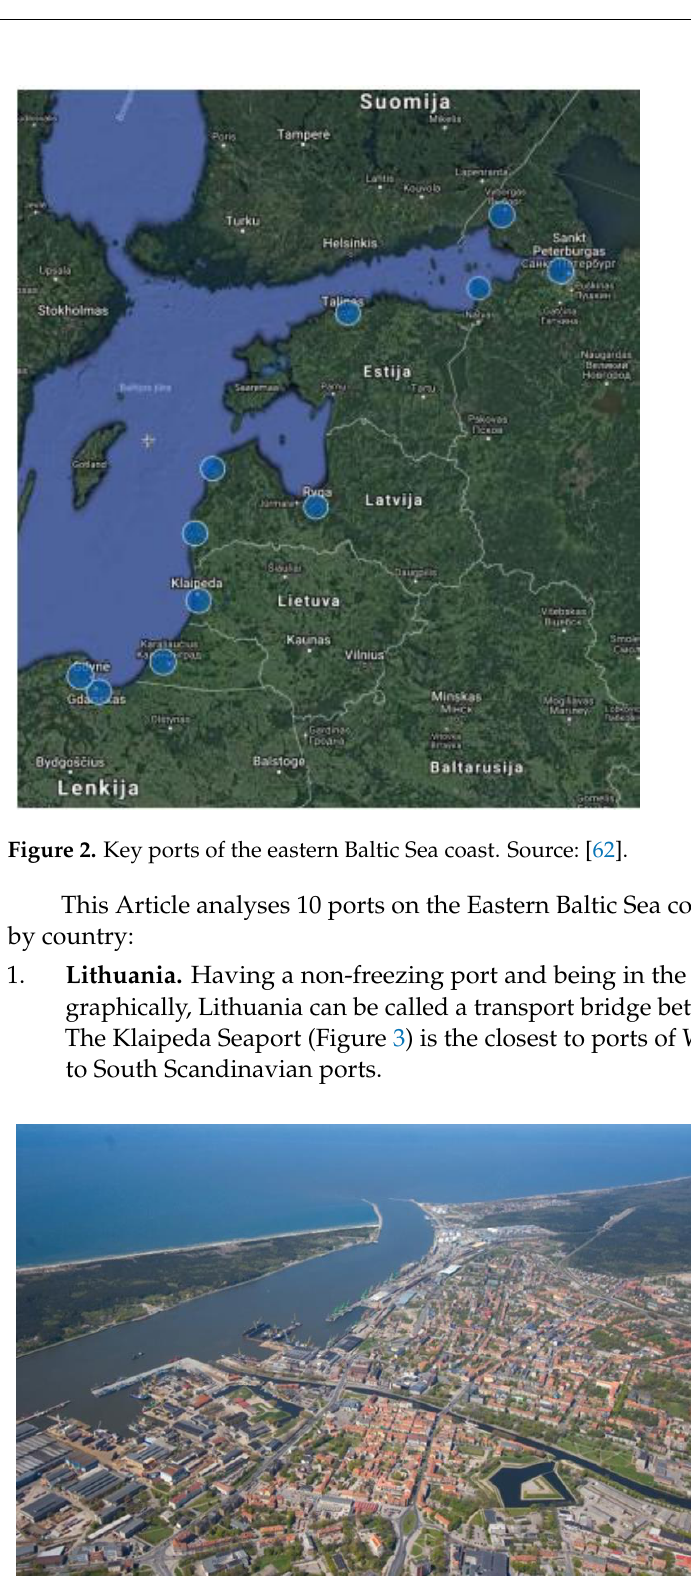
Figure 1. Transport corridors in the Baltic Sea region. Source: Adapted from Ref. [61].